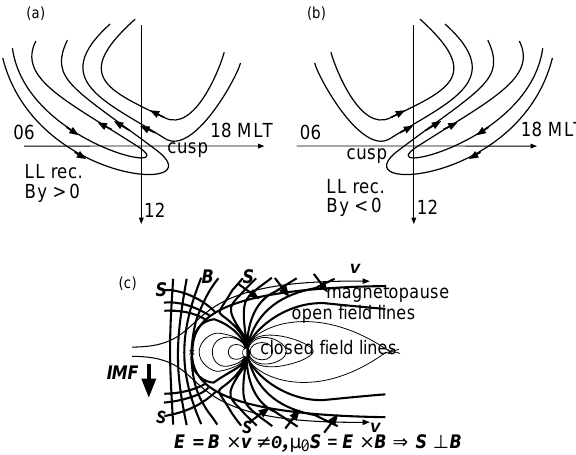
E = B × v ≠ 0, µ 0 S = E × B ⇒ S ⊥